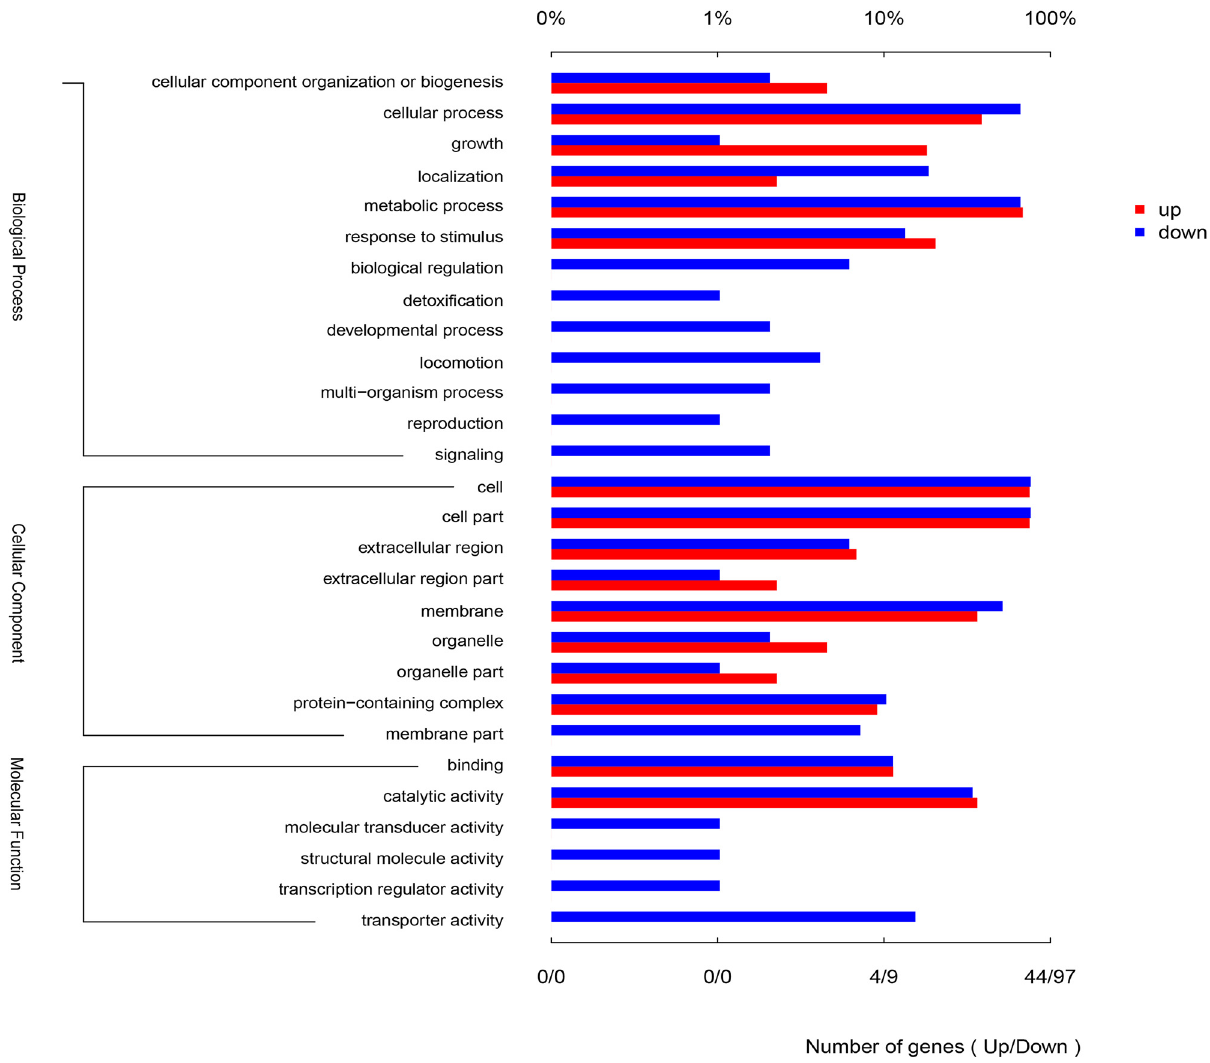
Figure 4: Chart summary of GO enrichment analysis under NaCl treatment. Three categories, namely, biological processes, cellular components, and molecular functions, are